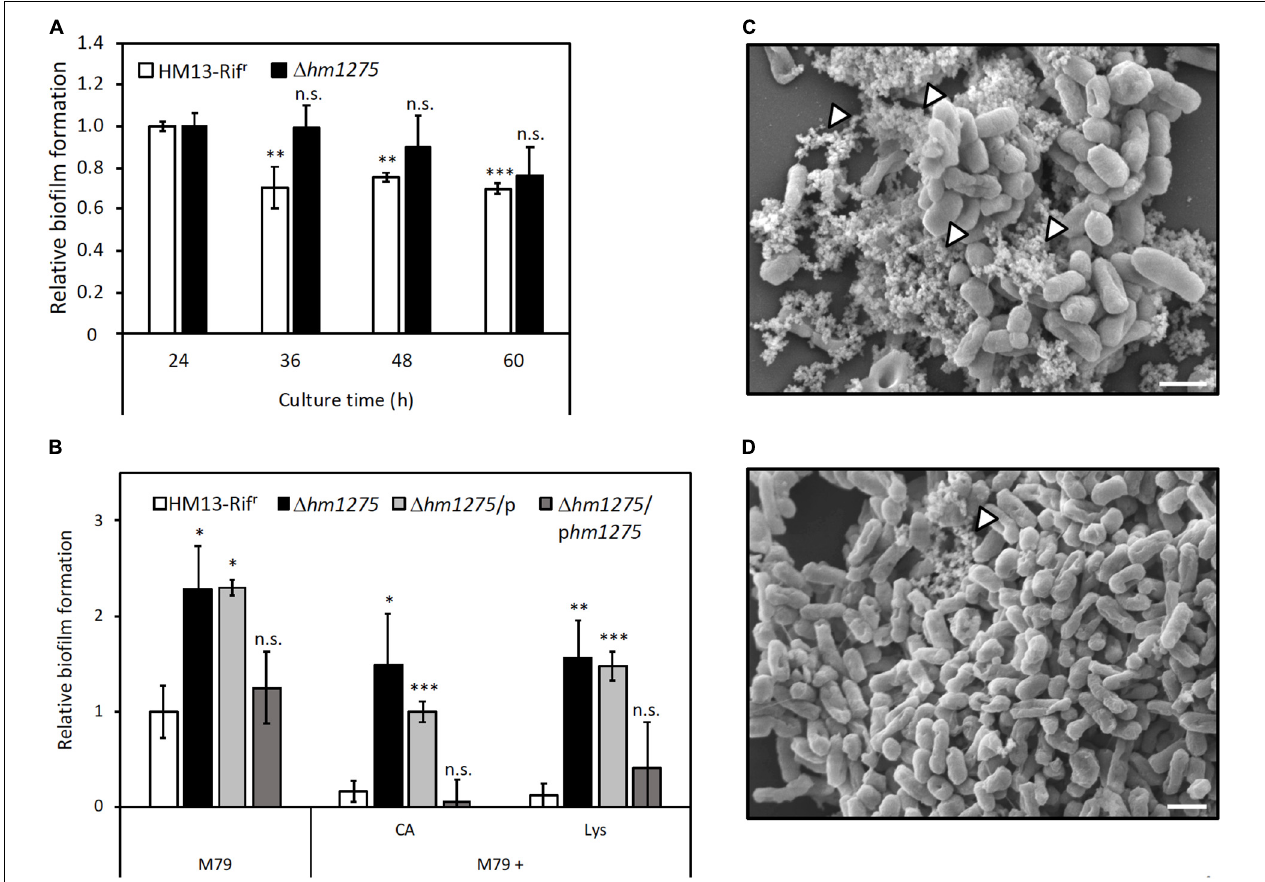
FIGURE 4 | Suppression of biofilm formation of S. vesiculosa HM13 by the addition of Lys. (A) The biofilm formation of HM13-Rif r and (cid:49) hm1275 cultured in M79 + CA was quantified in time-course by staining with CV. (B) Biofilm formation of HM13-Rif r and (cid:49) hm1275 in modified M79 media was quantified after 72 h of cultivation by staining with CV. The data are the means ± relative standard errors of the values from three independent batches. Statistical analyses for differences between 24 h and other culture times (A) and for differences between HM13-Rif r and other strains in each cultivation condition (B) were performed using two-tailed unpaired Student’s t -test. n.s., ∗ , ∗∗ , and ∗∗∗ indicate p ≥ 0.1, and p < 0.1, 0.05, and 0.01, respectively. (C,D) The fine structures of biofilm of HM13-Rif r (C) and (cid:49) hm1275 (D) cultured in M79 + CA were observed by SEM. The white arrowheads indicate stackings of EMV-like structures. The bars indicate 1 µ